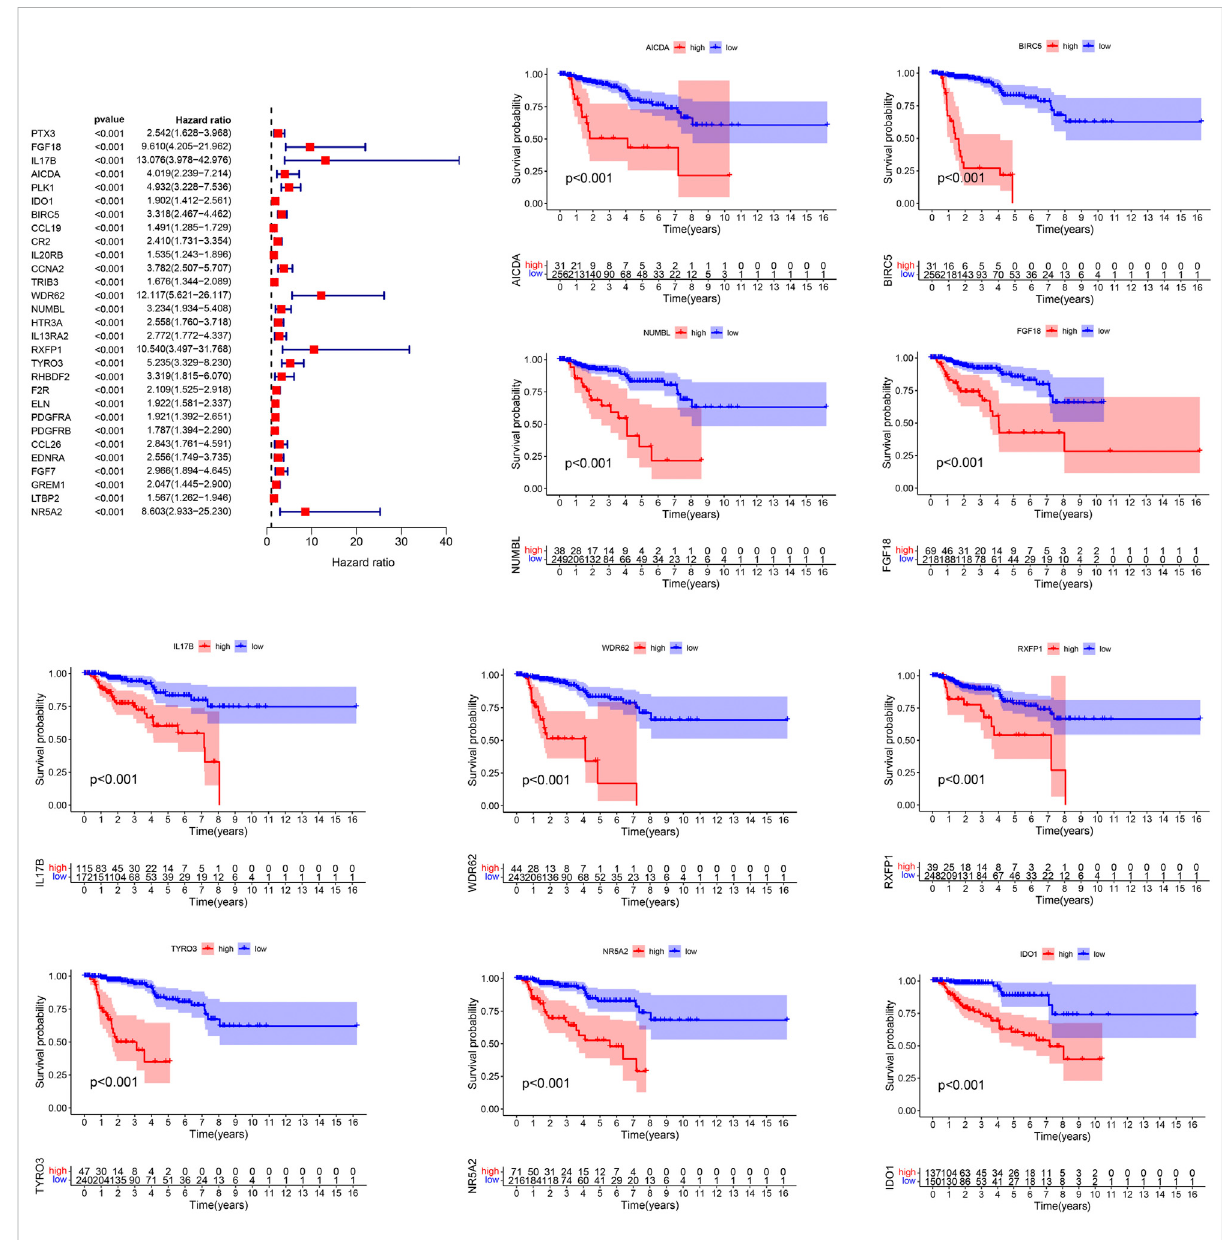
FIGURE 4 Prognostic values of survival-related IRGs. p values < 0.05 were considered to be statistically signi fi cant. IRGs, immune-related